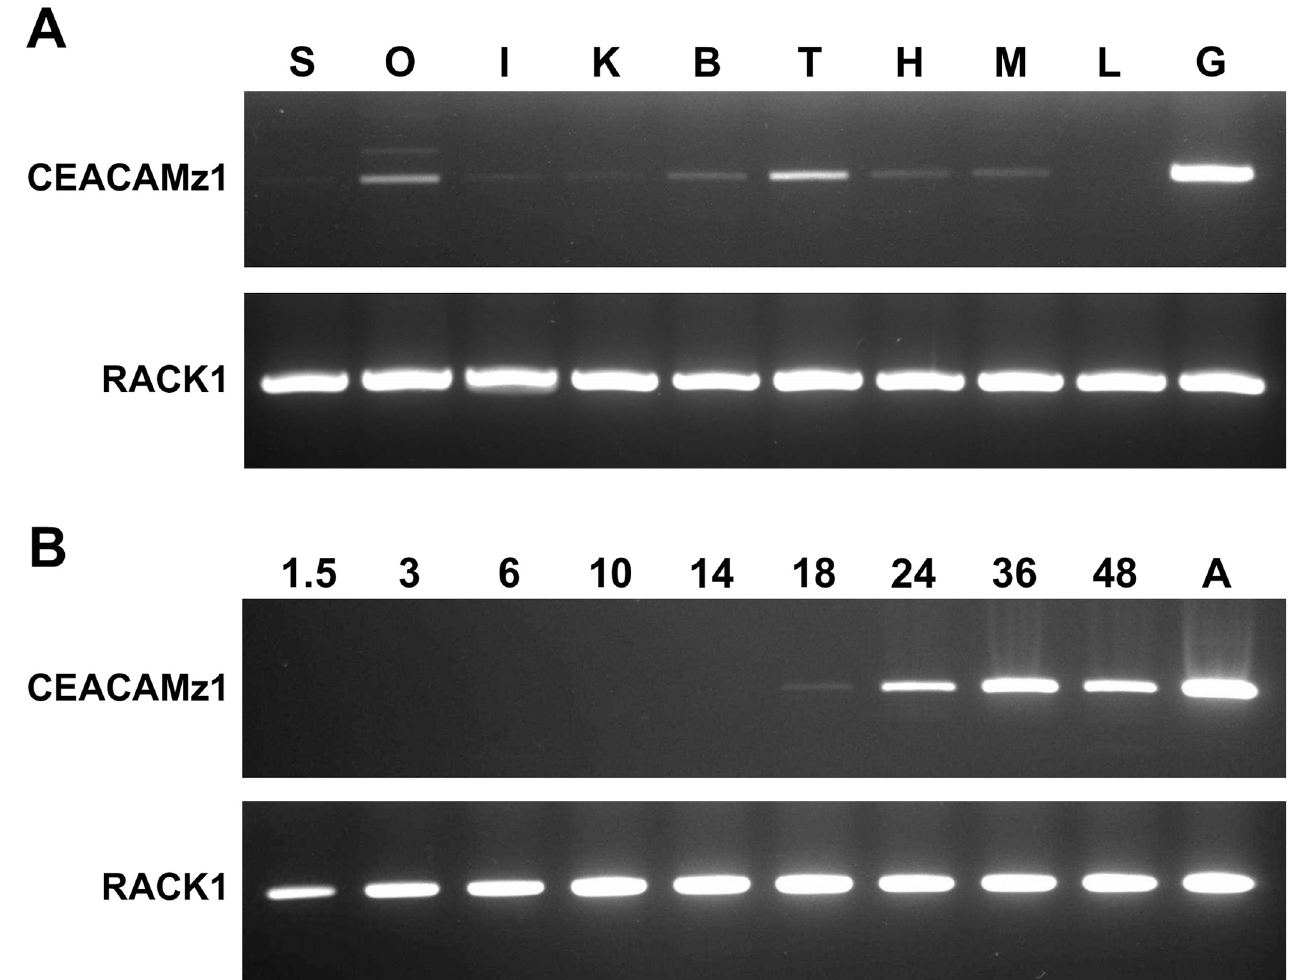
Fig 3. Spatial and temporal distribution of ceacamz1 mRNA. A. RT-PCR analysis of ceacamz1 expression in various tissues of adult zebrafish. S: Skin; O: Ovary; I: Intestine; K: Kidney; B: Brain; T: Testis; H: Heart; M: Muscle; L: Liver; G: Gills. B. RT-PCR analysis of ceacamz1 expression during development. The developmental stages analyzed are indicated in hpf above each lane. “A” refers to adult stage ( > 30 dpf). The constitutive rack1 gene was used as control in both sets of experiments.